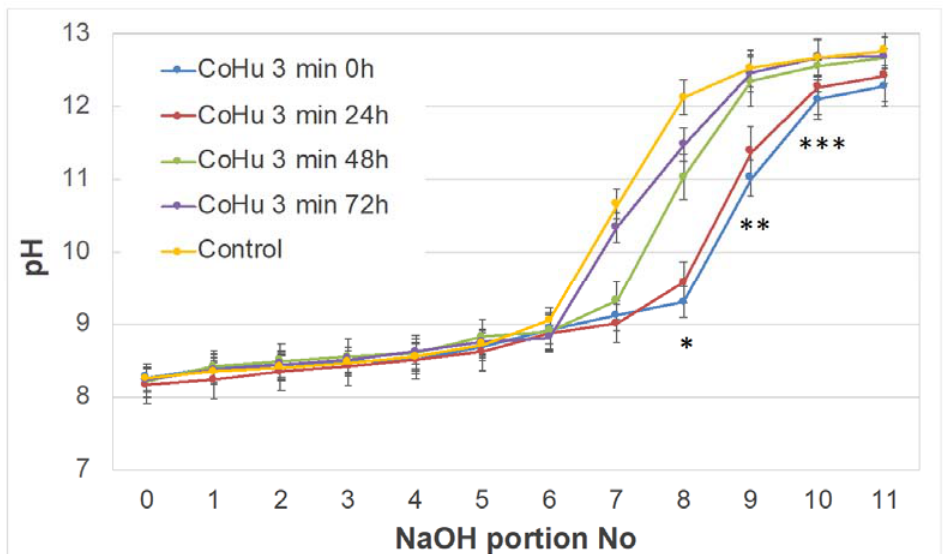
Figure 9. Averaged 0.01 M bicarbonate buffer titration curves with 0.1 M NaOH. Samples were treated with CoHu for 3 min